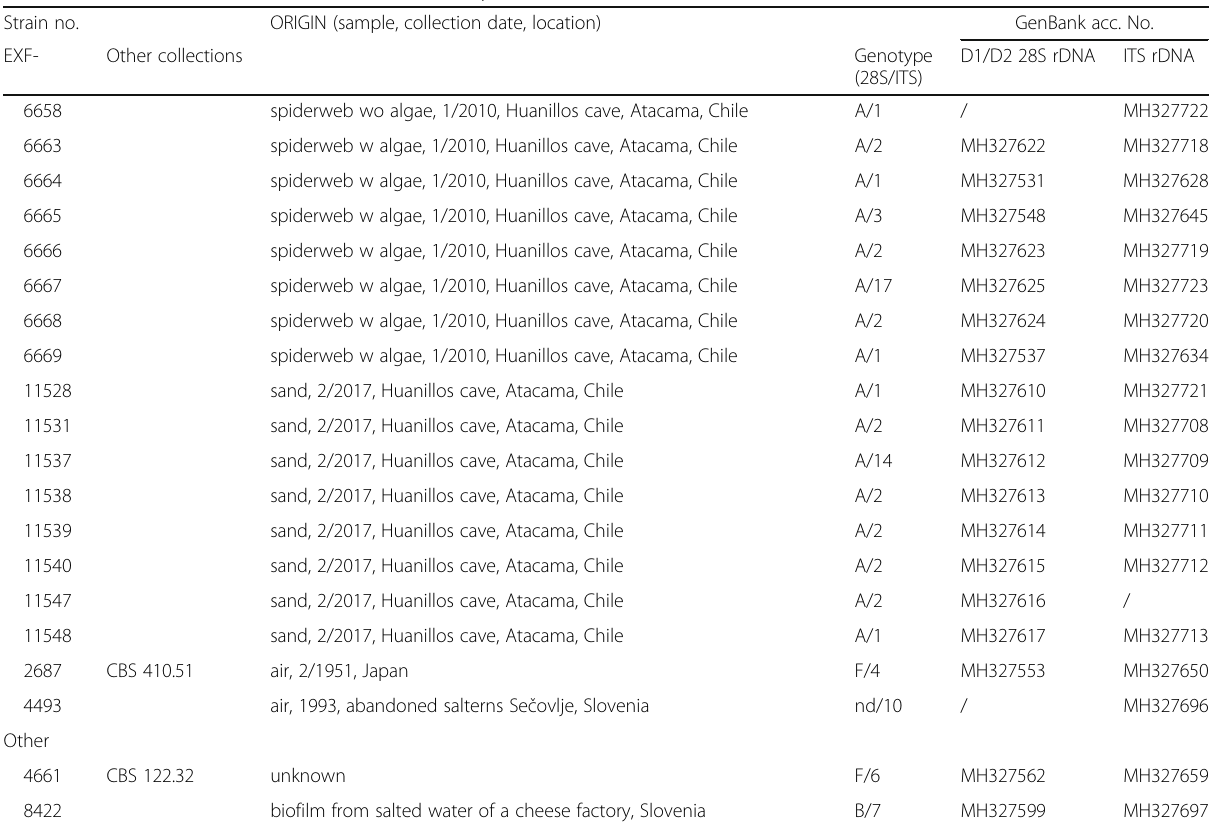
Table 1 Hortaea werneckii strains treated in this study (Continued) Strain